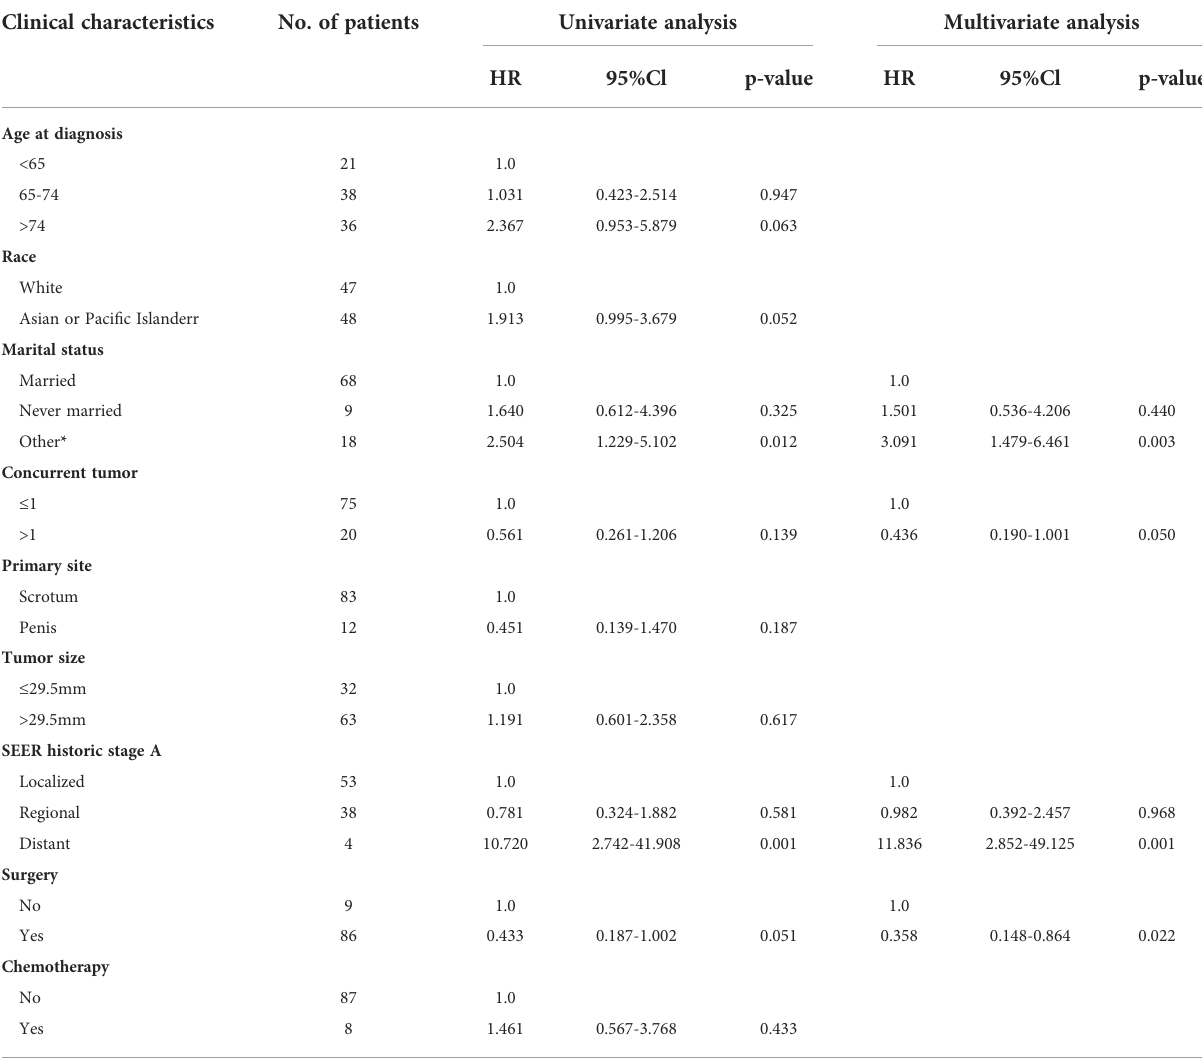
TABLE 3 Univariate and multivariate analyses of OS in the training cohort. Clinical